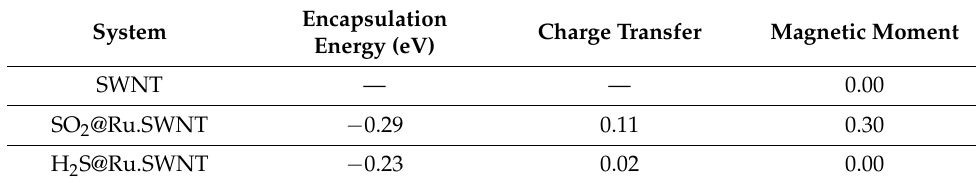
Figure 4. ( a ) Relaxed structure of a single SO 2 molecule encapsulated within the Ru ‐ doped SWNT, ( b ) charge density plot showing the interaction of SO 2 molecule with the nanotube, and ( c ) the total DOS plot of the encapsulated configuration. Similar plots are shown for H 2 S encapsulated SWNT ( d – f ). Vertical dashed lines correspond to the Fermi level. Table 3. Calculated encapsulated energies with respect to molecules, the amount of charge transferred between the nanotube and the molecule and net magnetic moments of pristine nanotube and the adsorbed complexes.